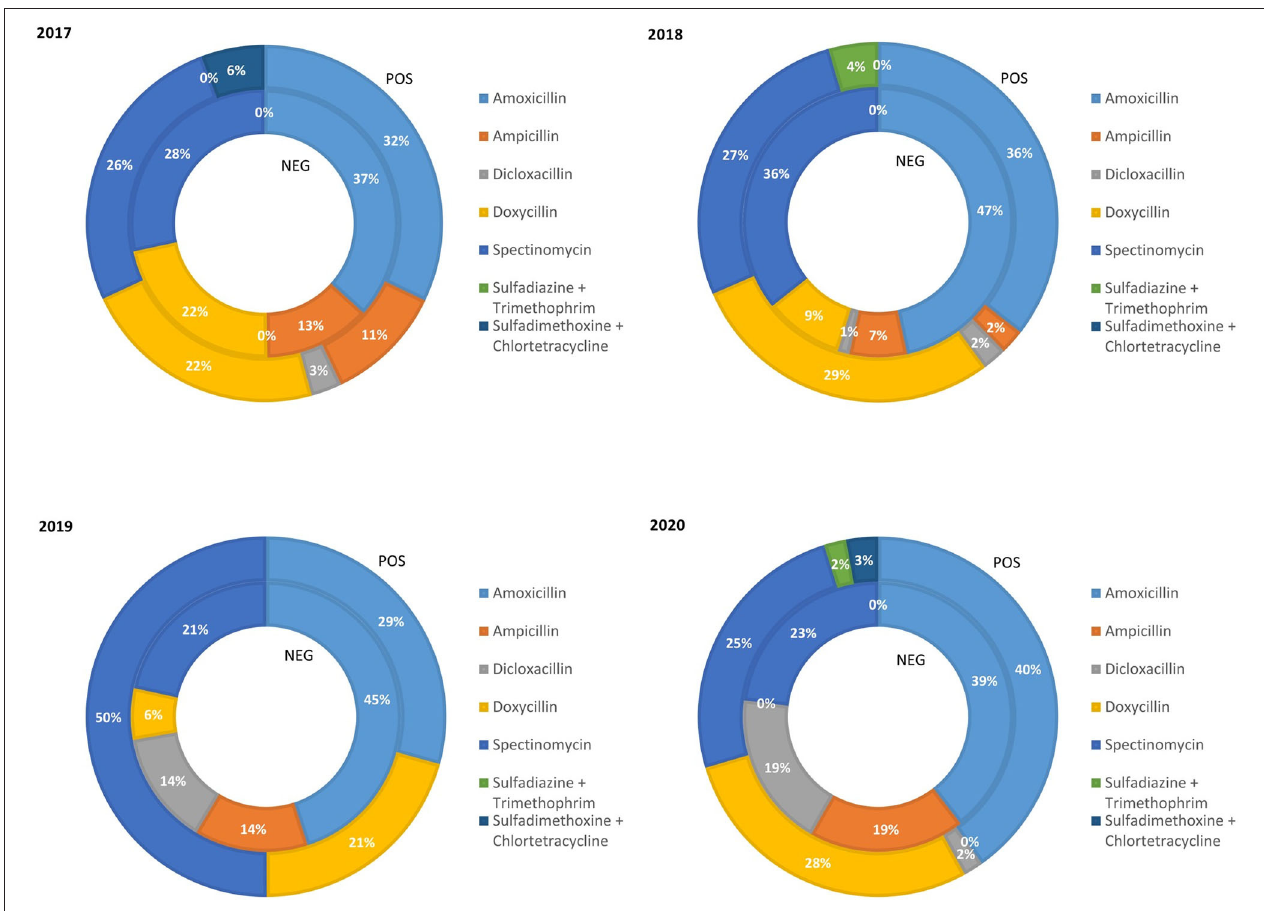
FIGURE 2 | Relative quantity of weaning pig weight treated with class D antibiotics in the PRRS negative (NEG) and PRRS positive (POS) production chains from 2017 to 2020.